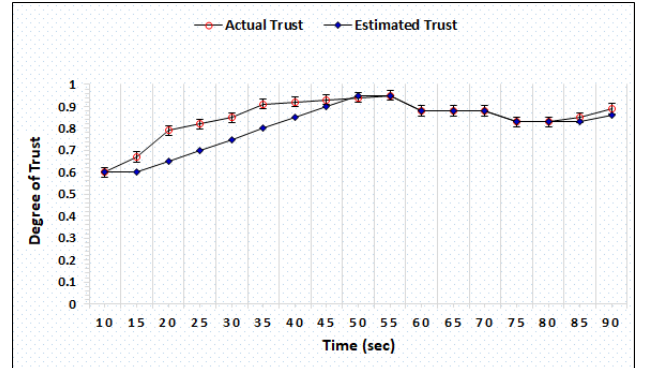
Figure 9. Trust degree of dishonest base station.